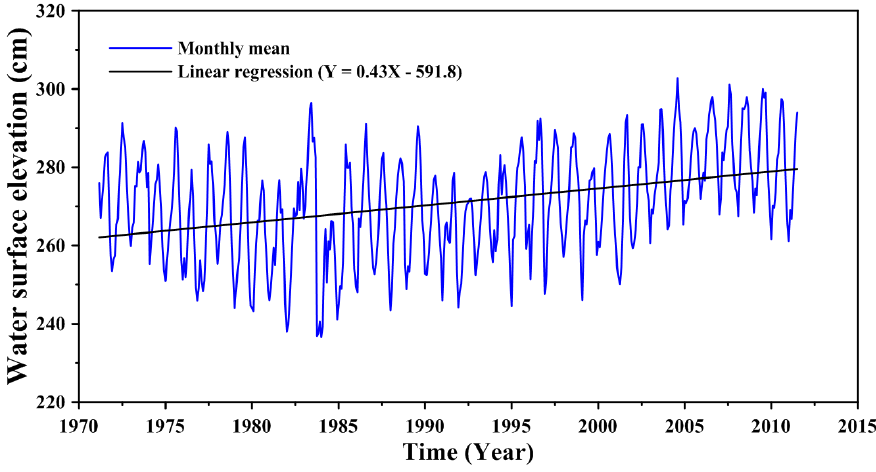
Figure 2. Linear regression for the sea level rise trend at the Taichung Harbor